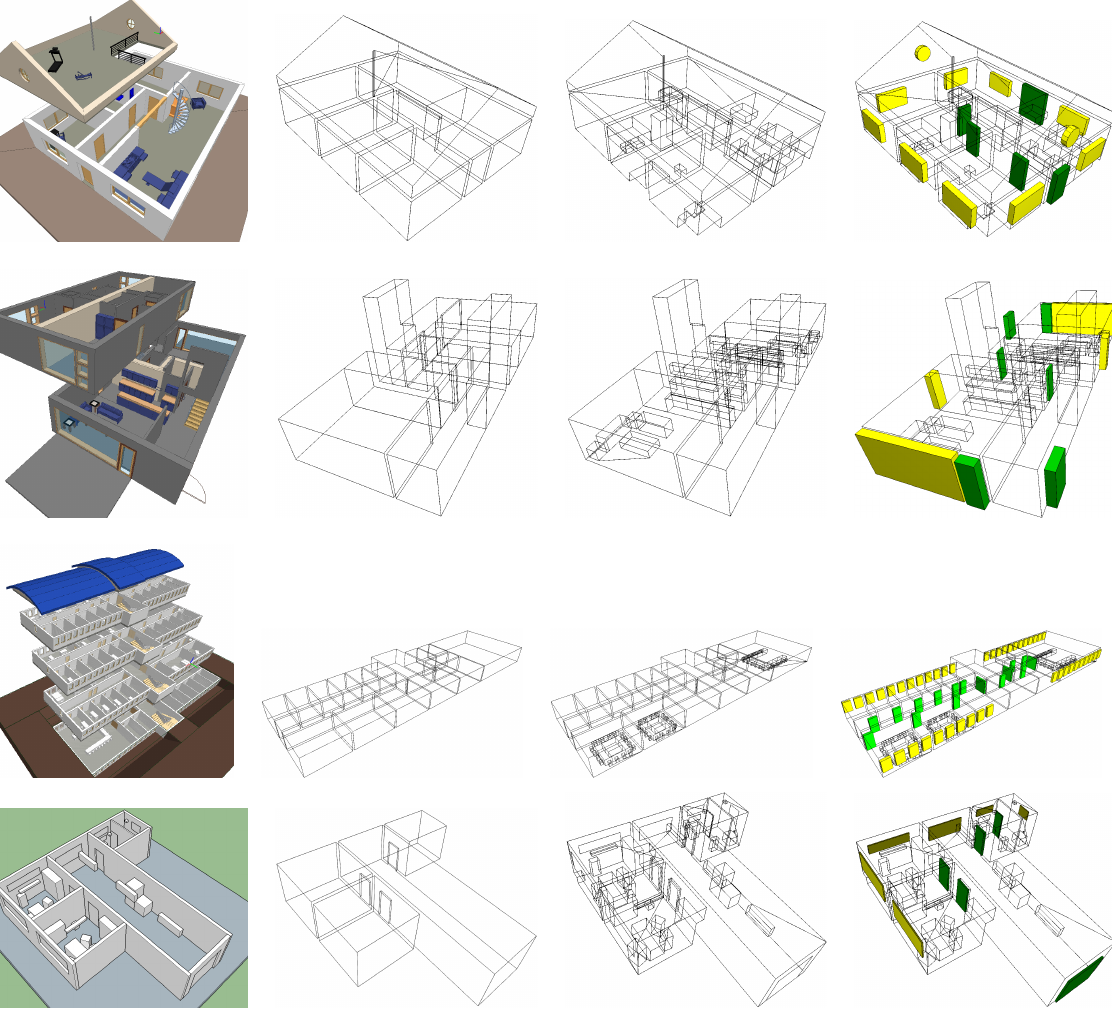
Figure 11: Extraction of the free space in the models of Table 1. From left to right, the first column shows the original models, the second shows the spaces ignoring the furnitures, the third illustrates the real free spaces considering the furnitures and the final column exposes the opening linked to the spaces (doors in green and windows in yellow). Only results on one floor is shown for some models, for clarity